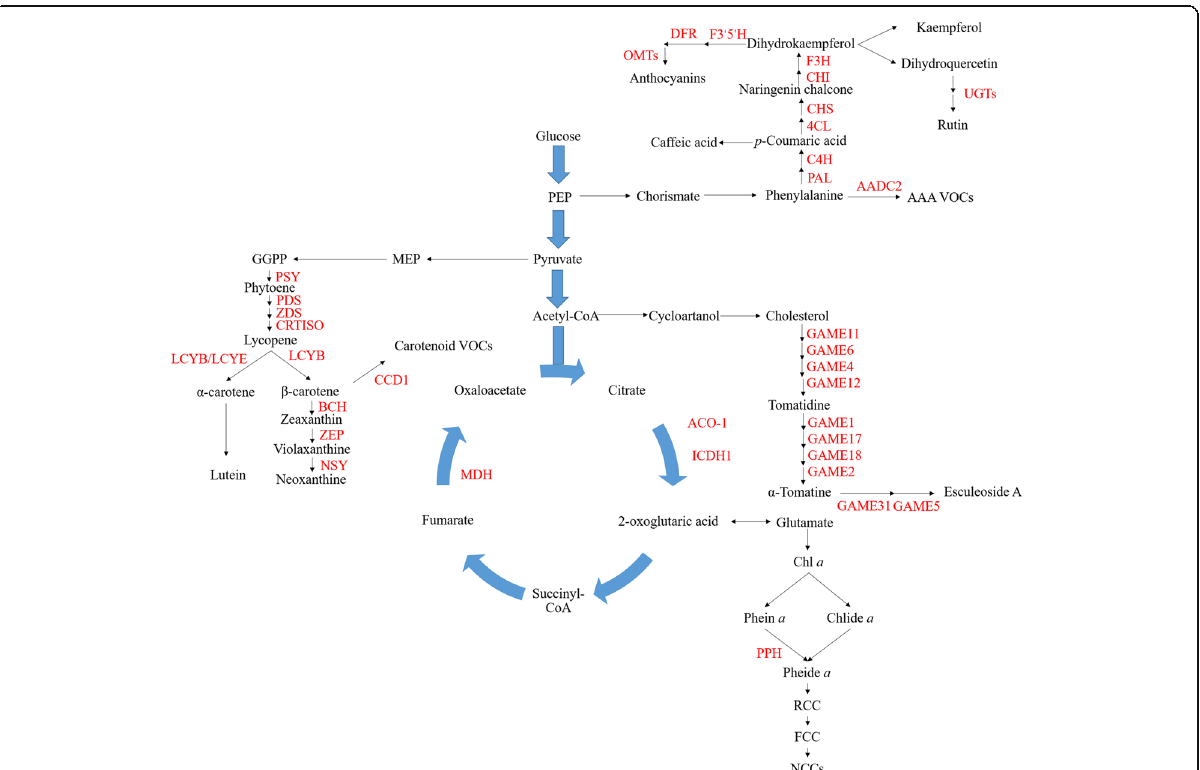
Fig. 1 Interrelationships of glycolysis, tricarboxylic acid cycle and fruit quality related metabolism. Names in black letters indicate the metabolite and names in red letters indicate the validated enzymes. VLC Acyl-CoA: Very-long-chain Acyl-CoA; Chl a: Chlorophyll a; Phein a: Pheophytin a; Chlide a: Chlorophyllide a; Pheide a: Pheophorbide a; RCC: Red chlorophyll catabolite; FCC: fluorescent chlorophyll catabolite; NCCs: Nonfluorescent chlorophyll catabolites. ACO-1: Aconitase-1; ICDH1: Isocitrate dehydrogenase 1; MDH: Malate dehydrogenase; PSY, phytoene synthase; PDS, phytoene desaturase; ZDS, ζ -carotene desaturase; CRTISO, carotenoid isomerase; LCYB, lycopene beta cyclase; LCYE, lycopene epsilon cyclase; BCH, β -carotene hydroxylase; ZEP, zeaxanthin epoxidase; NSY, neoxanthin synthase; CCD1, carotenoid cleavage dioxygenase1; PPH: Pheophytin pheophorbide hydrolase; PAL: Phenylalanine ammonia-lyase; C4H: Cinnamate 4-hydroxylase; 4CL: 4-coumarate CoA ligase; CHS: Chalcone synthase; CHI: Chalcone isomerase; F3H: Flavanone 3-hydroxylase; F3'5'H: Flavonoid 3'5'-hydroxylases; DFR: Dihydroflavonol 4-reductase; OMTs: O-methyltransferases; UFGT: UDP glucose flavonoid 3-O-glucosyl transferase; AADC2: Aromatic amino acid decarboxylase 2;